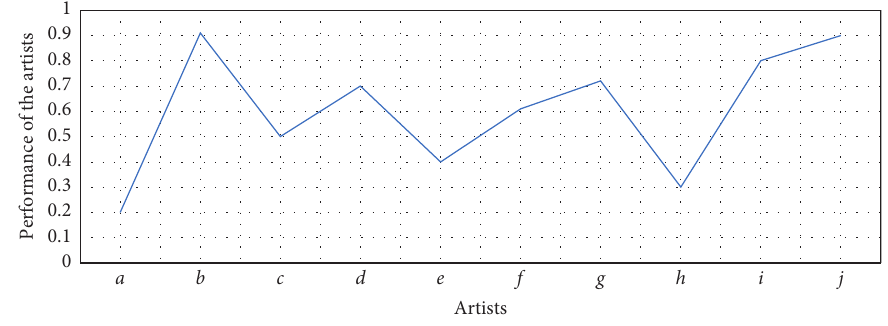
Figure 1: A graphical overview of Table 1. Table 2: Performance of the artists after the first phase. Artists Roughness of the